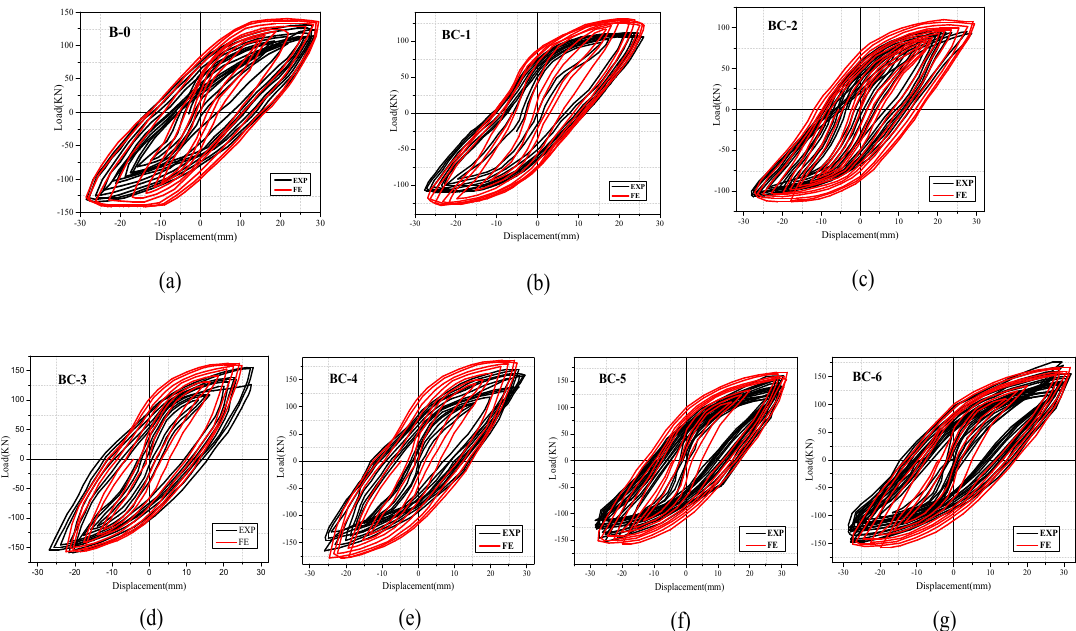
Figure 14. Comparison of hysteretic curve for experiment and FE: ( a ) B-0, equivalent M1, ( b ) BC-1 equivalent M2, ( c ) BC-2, equivalent M3, ( d ) BC-3, equivalent M4, ( e ) BC-4, equivalent M5, ( f ) BC-5, equivalent M6, ( g ) BC-6, equivalent M7.